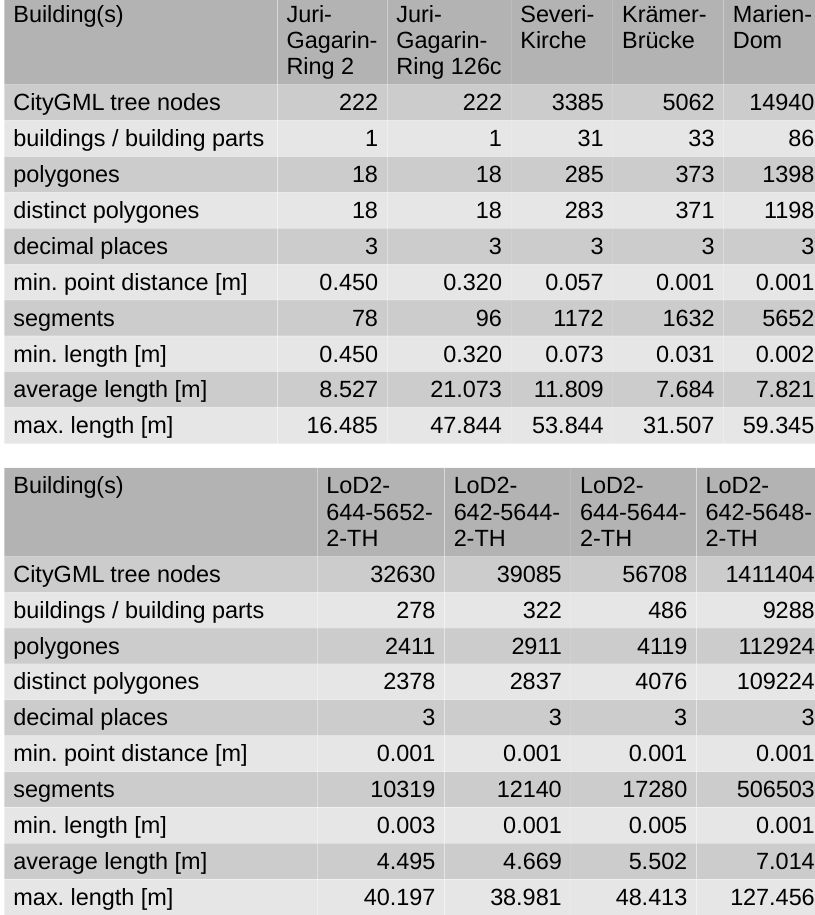
Figure 6. Data quality at (cid:101) = ε = σ = λ = 10 − 3 and ζ = 10 − 9 . The first step in the pipeline to create the results is to create each sub-node for each tetrahedron complex of the previously created aggregation node. All sub-nodes (see Figure 8 in yellow) are collected into one spatial access method ( SAM ) to support the next step. A thread pool calls the buildOverlay() operation on each sub-node to create the interior overlays in parallel. The buildOverlay(...) operation calculates all strict intersections (border intersections are ignored) with a set of given nodes. Each node-to-node intersection is linked to a new node, and the new node is related to its parents in an aggregation relation. The set of the resulting tetrahedral interior overlay nodes (see Figure 8 in green) are the shared solid volumes of the groups, since the Algorithm 1 for each group returned inner disjoint tetrahedralised tetrahedron complexes. The next step is to retrieve each border sub-node of each sub-node in order to calculate the border interior overlay of the set of border sub-nodes in parallel, just as the interior overlay calculation of the sub-nodes for the inner disjoint tetrahedron complexes previously. The set of the resulting border interior overlay sub-nodes (see Figure 8 in blue) are the shared border areas, curves and points of the border sub-nodes. The shared border areas, curves and points include the inner border areas, curves and points of all groups, since the tetrahedralisation of a group may result in the aggregation of several tetrahedron complexes (see previous paragraph). Figure 7 shows the intersection geometry (top right) and the whole resulting T 0 -space (bottom